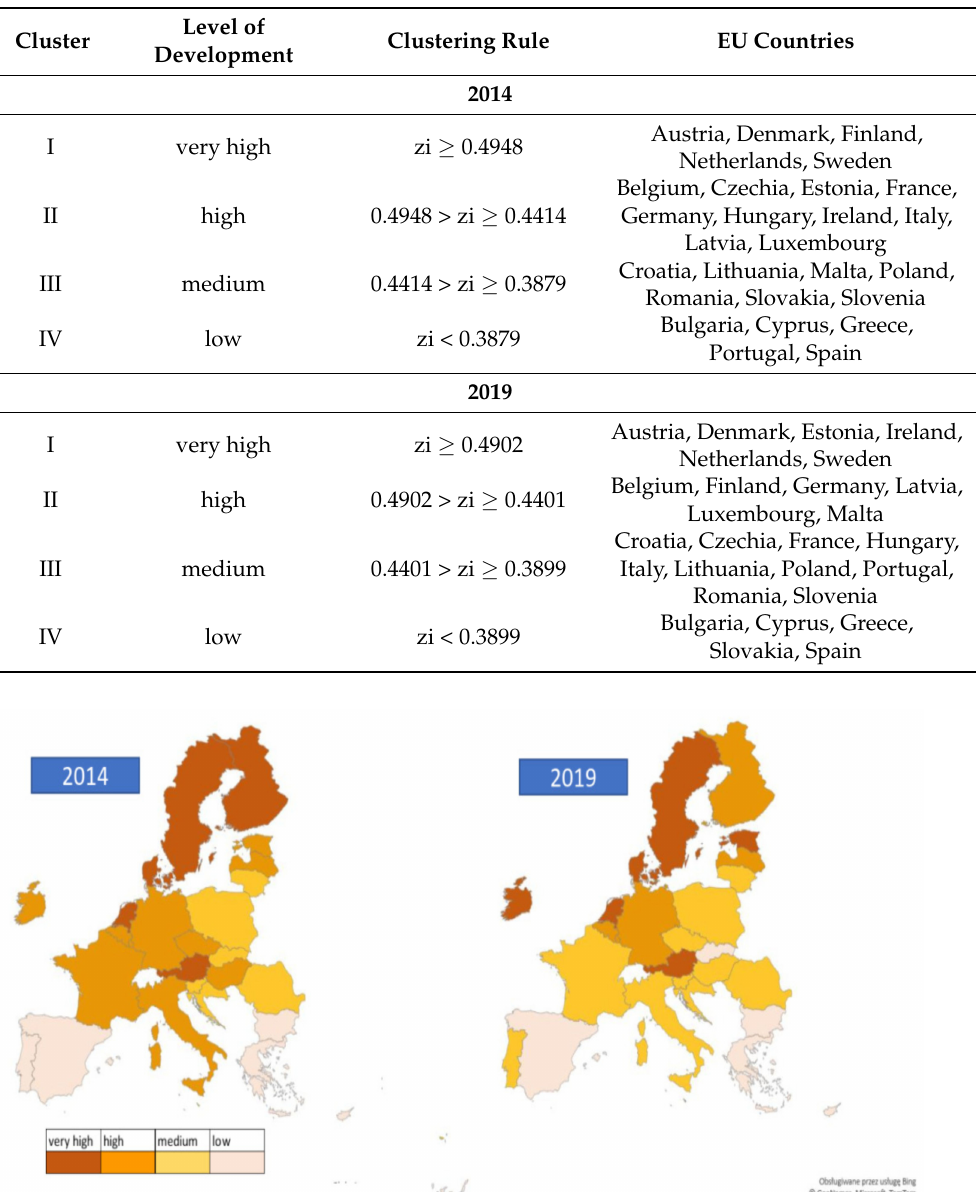
Table 5. Classification of EU countries into clusters: TOPSIS method.